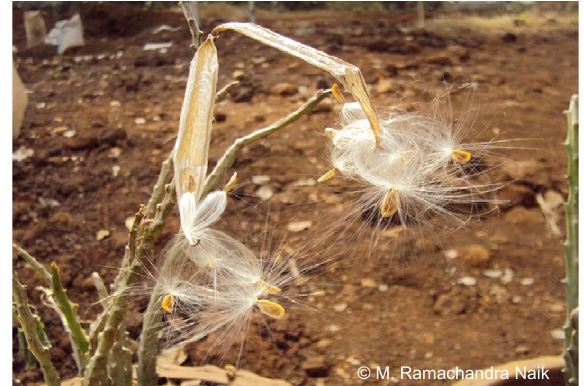
Image 2. Seed dispersal of Caralluma stalagmifera var .